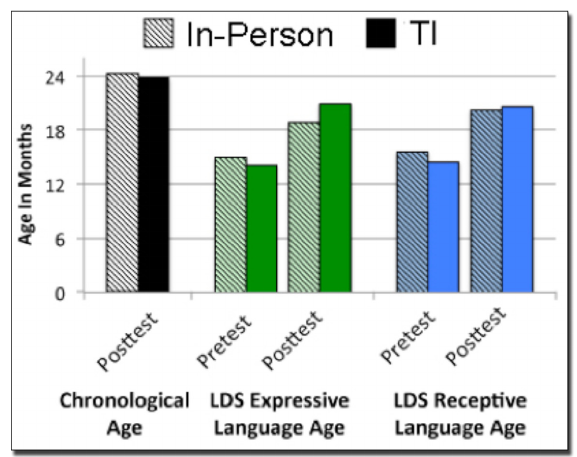
Figure 1. Pre- and post-test differences in LDS scores for In-person and TI